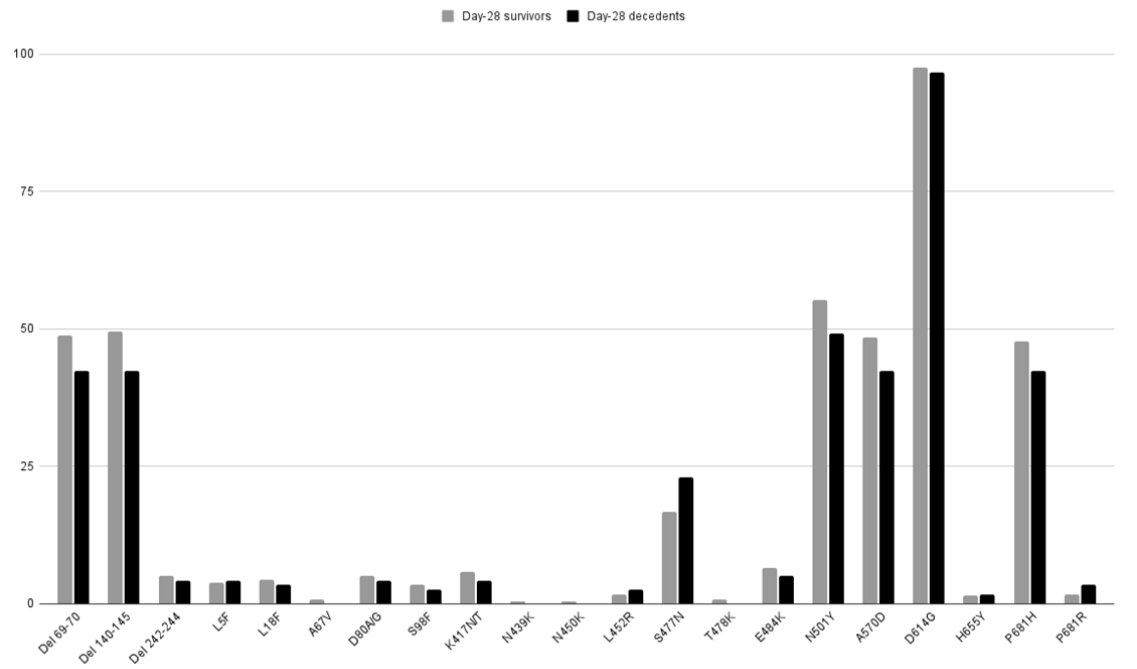
Figure 3. Frequency of preselected SARS-CoV-2 mutations in spike according to day-28 mortality status. There was no statistical difference in any of the comparisons performed (gray bars indicate survivors, black bars indicate deceased). Table 3. Association between SARS-CoV-2 variants, relevant mutations ((substitutions and deletions (Del)) in spike selected a priori and day-28 mortality by multivariable logistic regression analysis. All